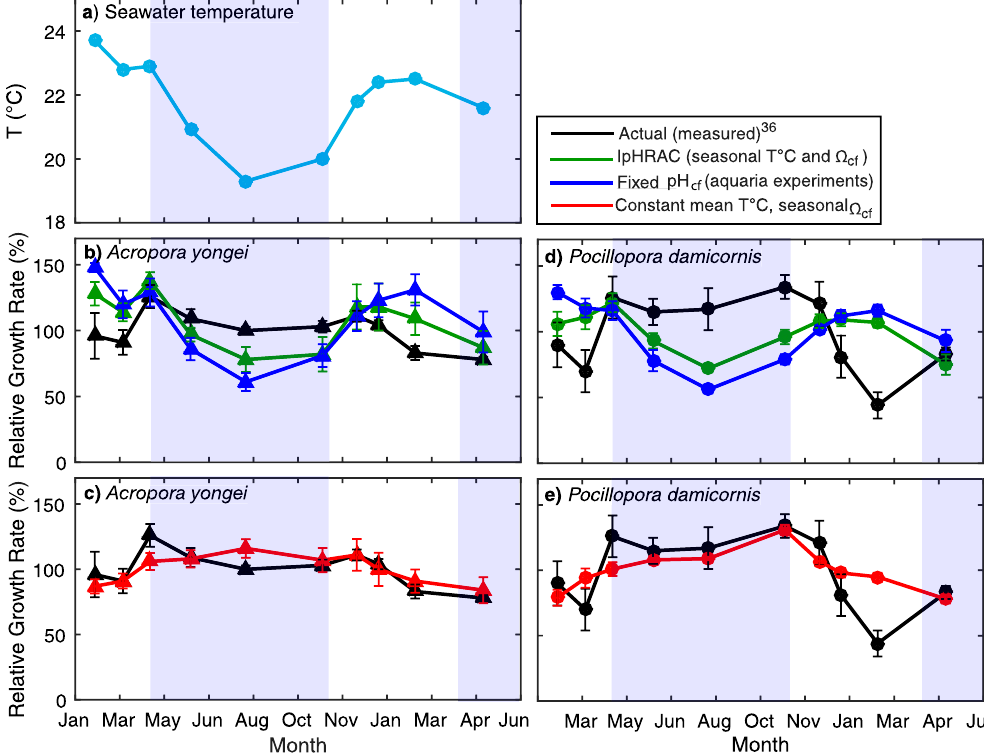
Figure 5. Measured and modelled seasonal growth rate response for branching Acropora yongei and Pocillopora damicornis at Rottnest Island. ( a ) Seasonal changes in average seawater temperature (°C). Actual calcification rates measured using the buoyant weight technique 36 and predicted calcification rates modelled using inorganic rate kinetics for ( b,c ) A. yongei , and ( d,e ) P. damicornis . Black symbols represent the measured calcification rates (mean ± 1 SE) for A. yongei ( n = 16) and P. damicornis ( n = 9) 36 . Green symbols represent the predicted calcification rates using seasonally varying temperature and seasonally varying Ω cf , blue symbols represent the predicted calcification rates using pH cf calculated from fixed condition experiments for Acropora spp., (y = 0.51pH sw + 4.28 40,49 ; where pH sw ranged from 8.03–8.10), and red symbols represent the predicted rates using a constant mean temperature (21.7 °C) and seasonally varying Ω cf. All growth rates are expressed as percentage relative to the mean. Light blue shading denotes winter and unshaded areas denote summer, defined based on seasonal changes in temperature and